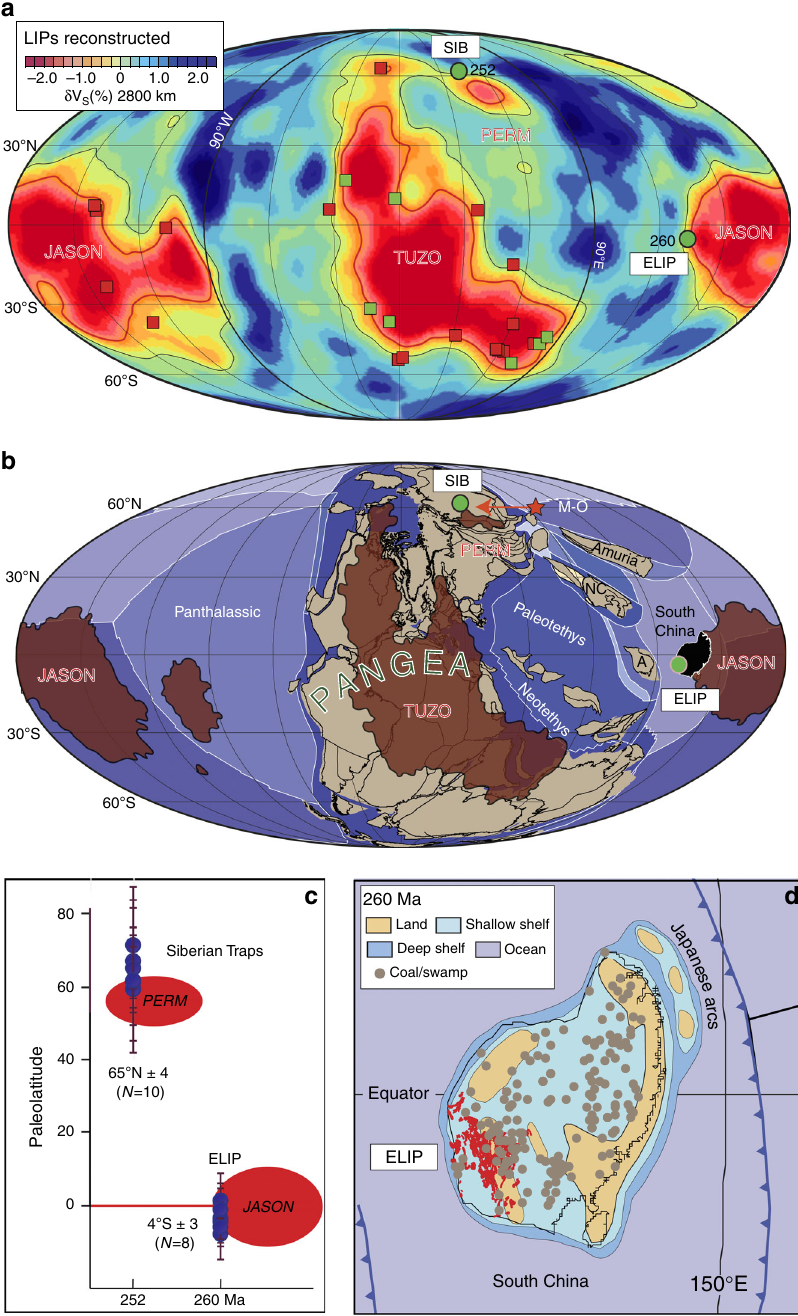
Fig. 1 Reconstruction of large igneous provinces. a Reconstruction of 26 large igneous provinces ( LIPs , 31 – 297Ma) using a hybrid reference frame 9 and draped on the s10 mean tomographic model 10 . The plume generation zone ( PGZ , thick red line ) in this model corresponds to the 0.9% slow contour and the zero contours are shown as thinner black lines . LIPs with red symbols reconstructed with moving and fi xed hotspot reference frames, while those with green symbols use a true polar wander-corrected palaeomagnetic reference frame. But the reconstruction of the 260 Ma Emeishan LIP ( ELIP ) is an exception: Although Pangea was amalgamated at 260Ma ( b ), the supercontinent did not include South China, which is therefore without longitudinal constraints. The ELIP is on the South China block, and palaeomagnetic results position it at latitudes around 4°S ( c ); if ELIP had erupted above a PGZ, there are several possible longitudinal locations where the line of latitude crossed the PGZ at that time. Pangea covered TUZO ( b ), leaving only the options related to JASON, and the reconstruction with ELIP above the western margin of Jason at ~134° E, is a realistic alternative. One should also note that net true polar wander was zero between 250 and 260 Ma 11 . b Pangea reconstruction at 260 Ma 7, 12 with plate boundaries and draped on seismic voting-map contour 4 in the lower mantle 6 . Here we only show the reconstructed location of the Siberian Traps ( SIB , erupting ~8 million years after the reconstruction) and the ELIP that erupted at the equator and linked to the margin of JASON. The red star is where Flament et al. 1 initiate the PERM anomaly at 190Ma (linked to the much older ELIP!) and later shifted westwards to its current location. A Annamia (Indo-China), M-O Mongol-Okhotsk Ocean, NC North China. c Palaeomagnetically derived palaeolatitudes from the Siberian Traps (10 studies) and Emeishan volcanics ( ELIP , 8 studies) with 95% con fi dence bars which form the basis for reconstructing South China at that time 11,12 . d Detailed 260 Ma reconstruction of South China with plate boundaries 7 and draped with Guadalupian (272 – 260 Ma) and Lopingian (260 – 252Ma) coal/swamp occurrences 13 that verify tropical (equatorial) humid conditions during the eruption of